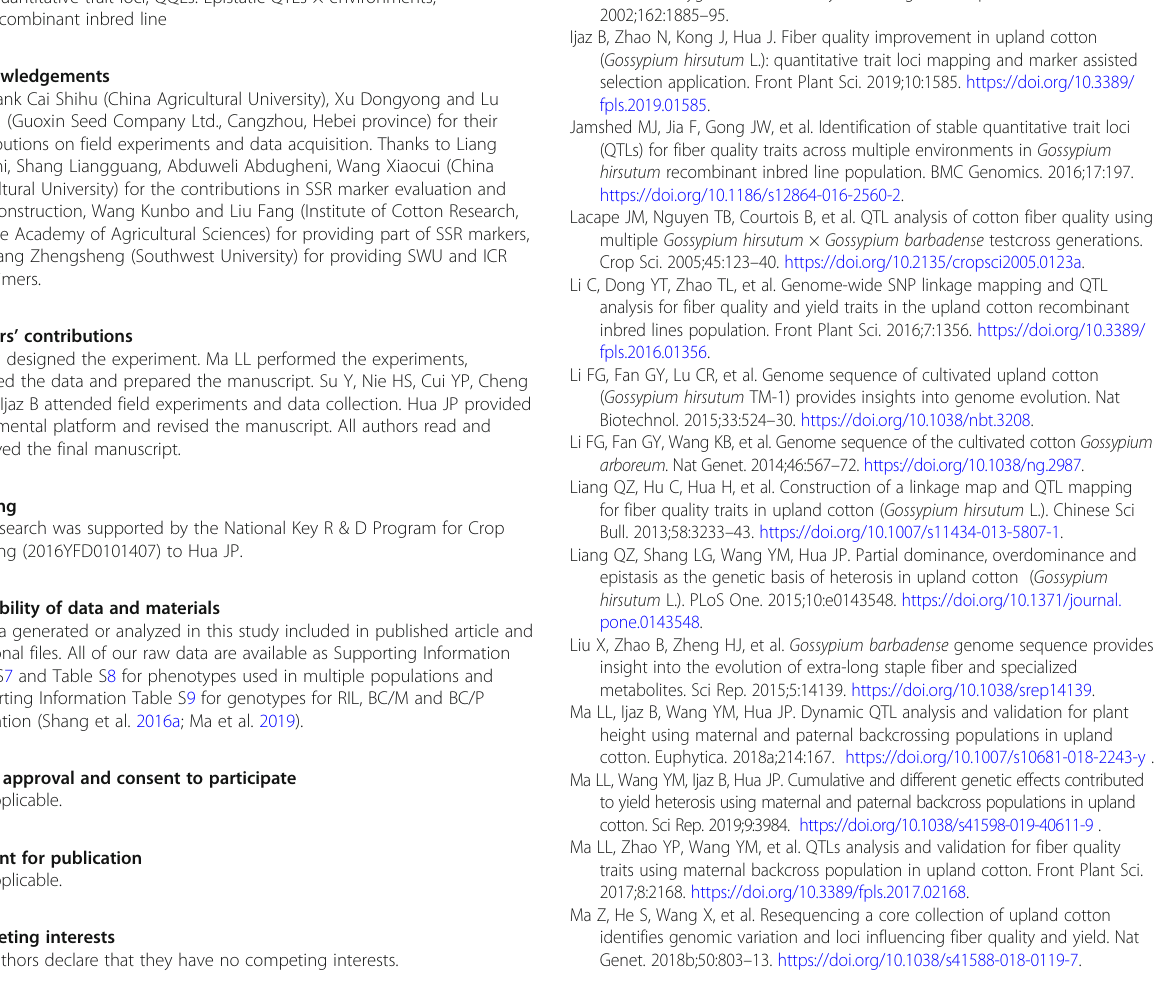
Additional file 2: Table S2. Main effects and environmental interactions detected for fiber quality traits in RIL-P population. Additional file 3: Table S3. Epitasis effects and environmental interactions detected for fiber quality traits in RIL-P population. Additional file 4: Table S4. Main effects and environmental interactions detected for fiber quality traits in BC/P population. Additional file 5: Table S5. Epitasis effects and environmental interactions detected for yield and its components in BC/P population. Additional file 6: Table S6. Common single locus QTLs in comparison with the previous studies in multiple years and locations. Additional file 7: Table S7. Phenotype values of fiber quality traits of BC/P population in three field trials in this study. Additional file 8: Table S8. Phenotype values of fiber quality traits in field trial of BC/M population in this study. Additional file 9: Table S9. Genotypes of RIL (A), BC/M (B) and BC/P (C)